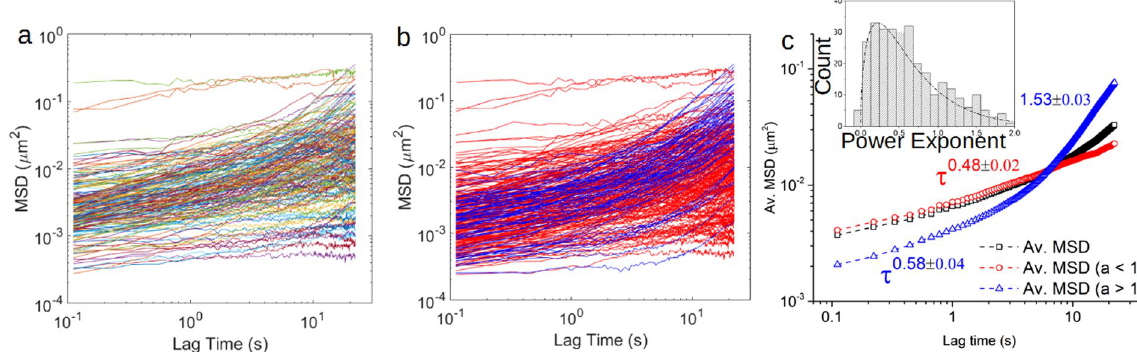
Figure 4. ( a ) The MSD curves as a function of lag time ( τ ) calculated for all the tracked ER tubules. ( b ) There were two distinct populations of MSDs based on their power law exponent, one with α < 1 (red) and one where 1 < α < 2 (blue) for lag times τ > 2 s. The black symbols show the average of the two populations i.e. when the distinction between subdiffusion and super-diffusion is not made. ( c ) The ensemble averaged MSD of the sub- diffusive population could be characterised by a universal power law with α = 0.48 ± 0.02, whereas the averaged MSD of the super-diffusive population has a power law of α = 0.58 ± 0.04 at small lag times and α = 1.53 ± 0.03 at long lag times, τ > 2 s. The inset in ( c ) shows a histogram of the power law exponents extracted from the individual tubules’ MSD